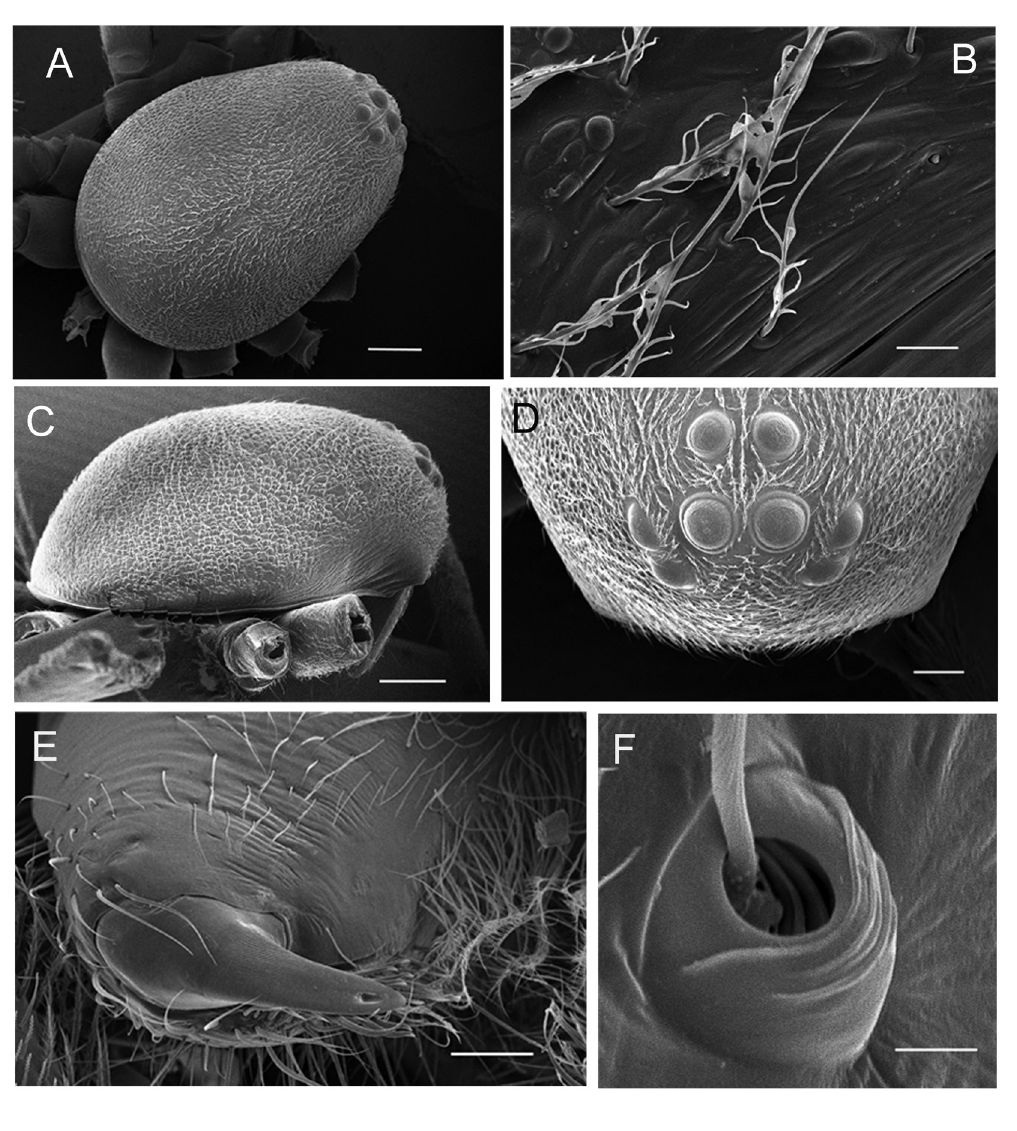
Fig. 2. Cambonilla securicula Jocqué gen. et sp. nov., male paratype (RBINS IG 33.889/002), scanning electron micrographs. A . Carapace, dorsal view. B . Branched setae near fovea. C . Carapace, lateral view. D . Eye region, frontal view. E . Chelicerae, ventral view. F . Trichobothrium on male palp, dorsal view. Scale bars A, C = 0.5 mm; B = 20 µm; D = 0.2 mm; E = 0.1 mm; F = 5